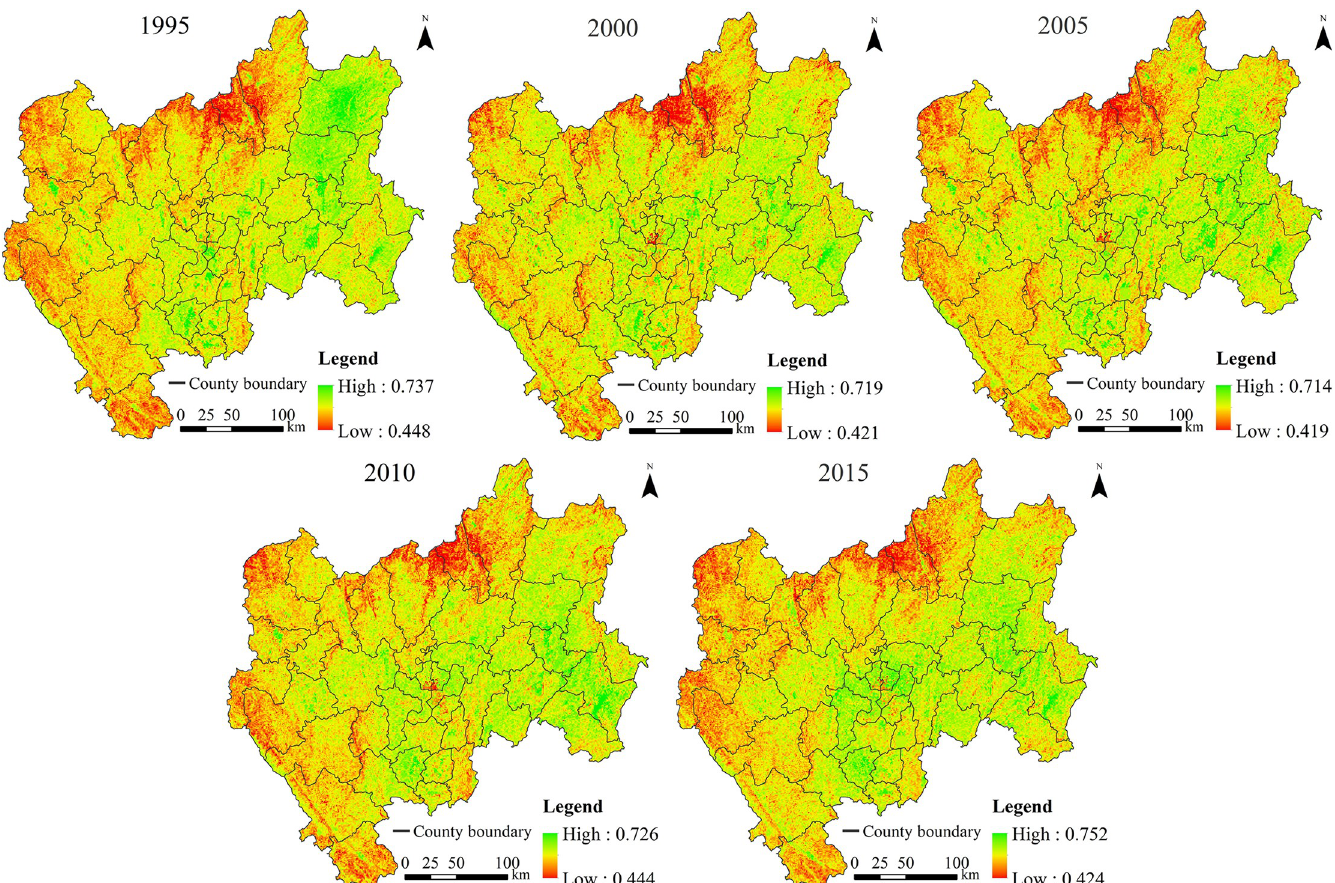
Fig 2. Distribution of the pixel-based ecological security index ( ESI ) in central Yunnan Province (CYP).